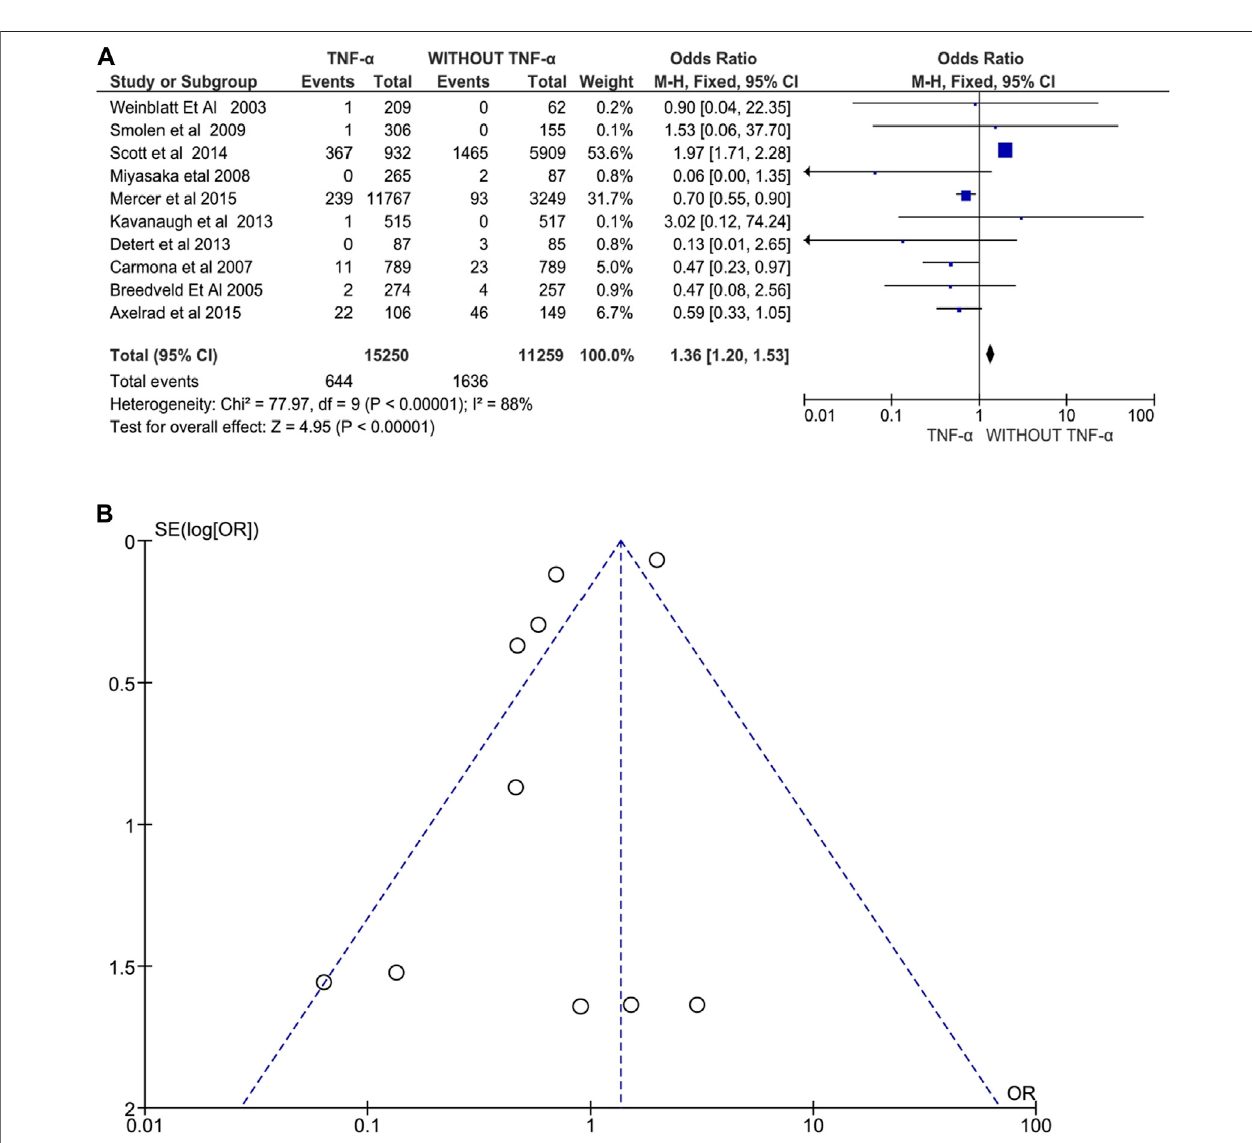
FIGURE 5 | (A) Forest plot for cancer incidence after treatment with anti-TNF α agents versus control group (without anti-TNF α agents) using a random-effects model. Odds ratios and 95% con fi dence intervals are shown. (B) Funnel plot for assessment of publication bias.